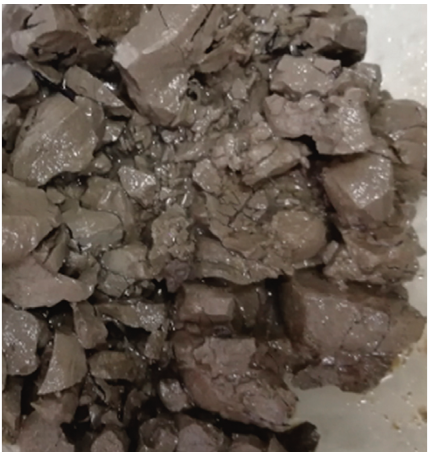
Figure 15: Disintegrated